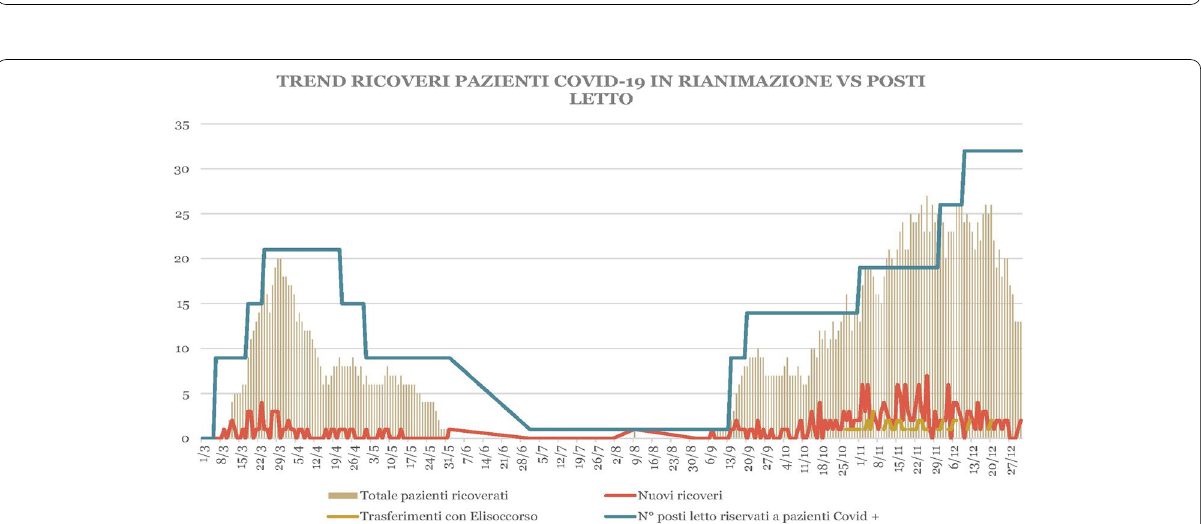
Fig. 4 Trends of number of ICU patients vs beds availability in Foggia from January 03, 2020, until January 01,